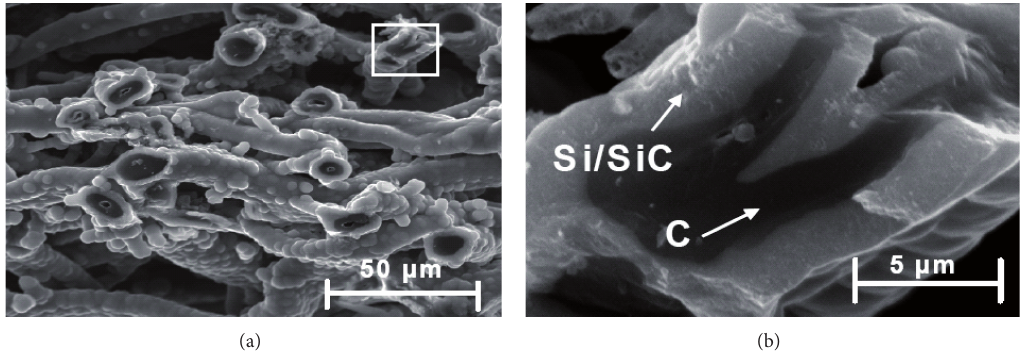
F 1: Scanning electron microscope (S�M) image of the ceramic in�ltrated with SiC by pyrolysis of MTS [5].